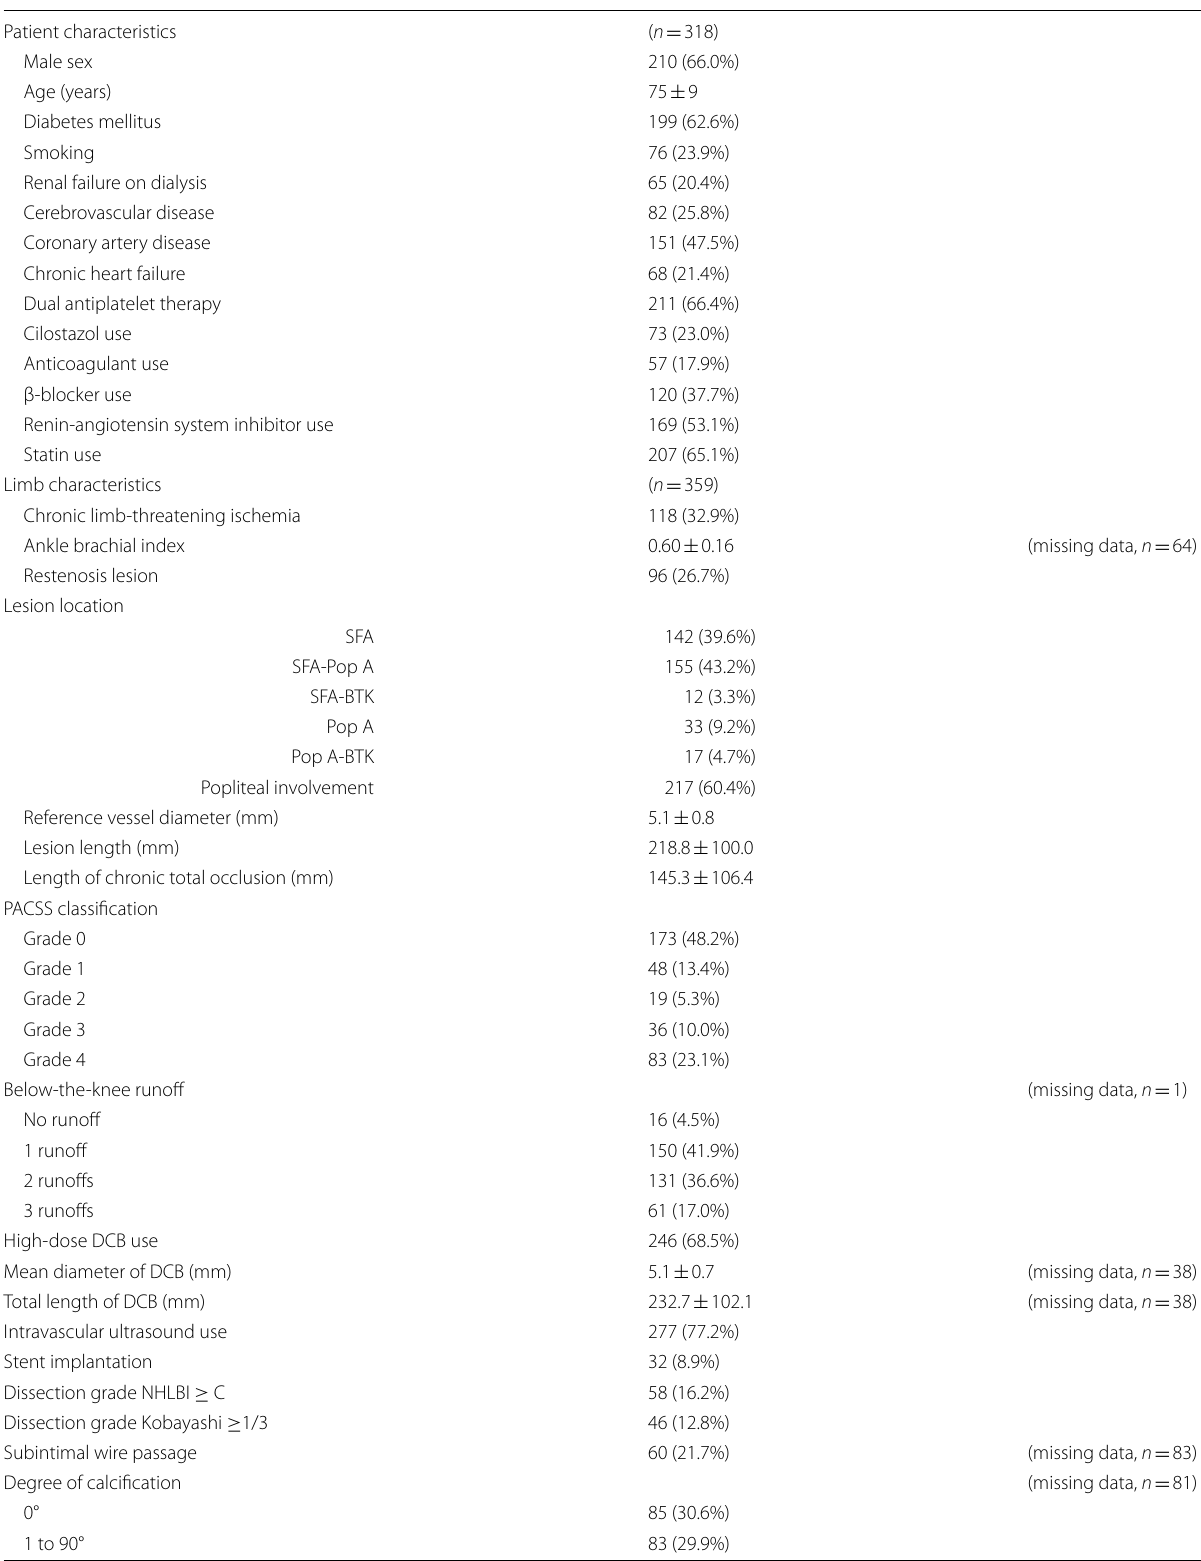
Table 1 Baseline